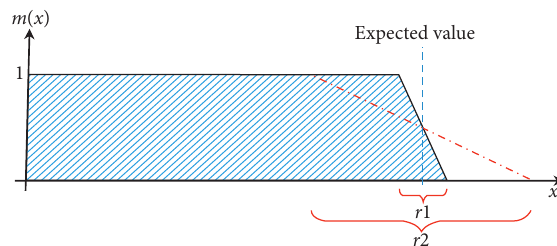
Figure 8: Impact of fuzzy parameter variations ( r ) over the MFs.